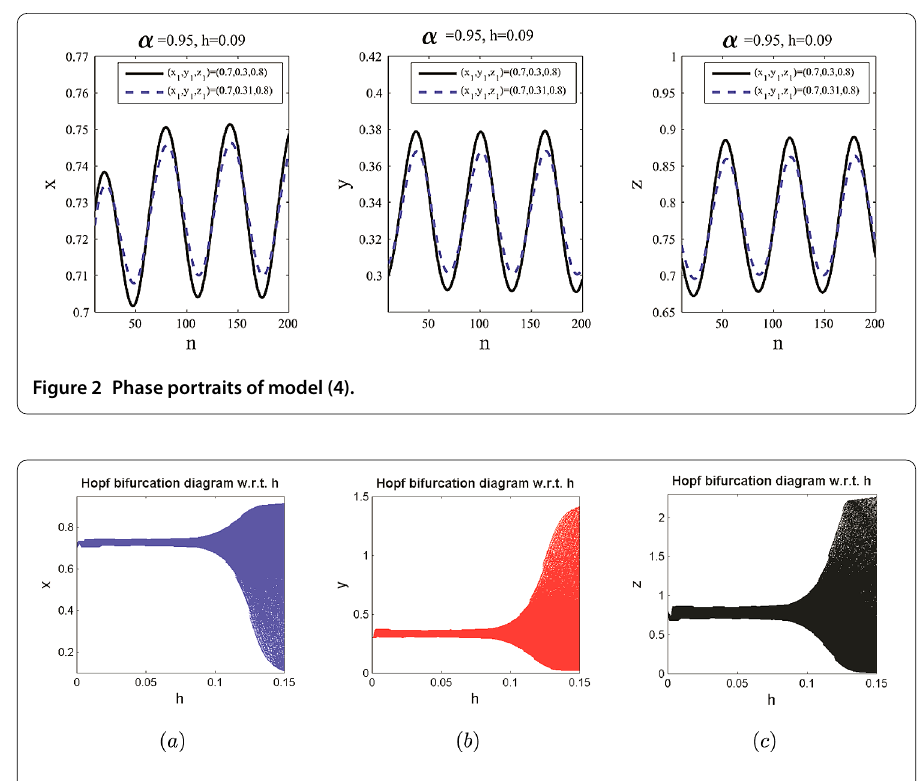
Figure 3 Hopf bifurcation diagram with respect to h